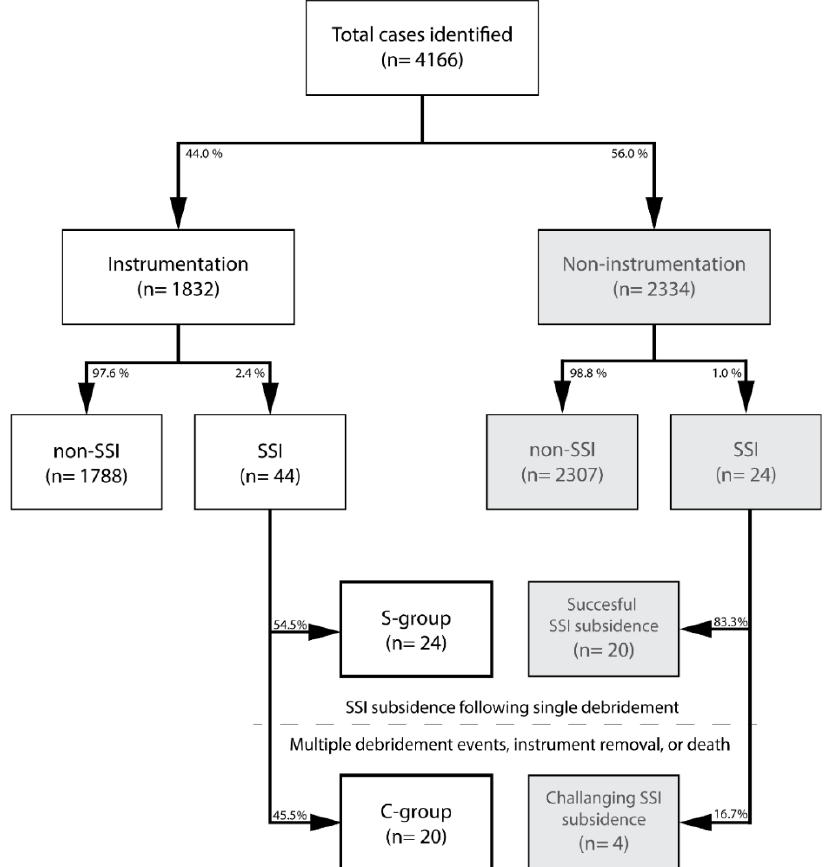
Figure 1. Flow chart depicting the study population and their respective categorization. Abbrevia- tions: SSI, surgical site infection occurring post-spinal surgery; S-group, successful treatment of SSI with single debridement in the instrumentation cohort; C-group, instrumentation cohort with SSI that underwent multiple debridement interventions, instrumentation removal, or succumbed to death.